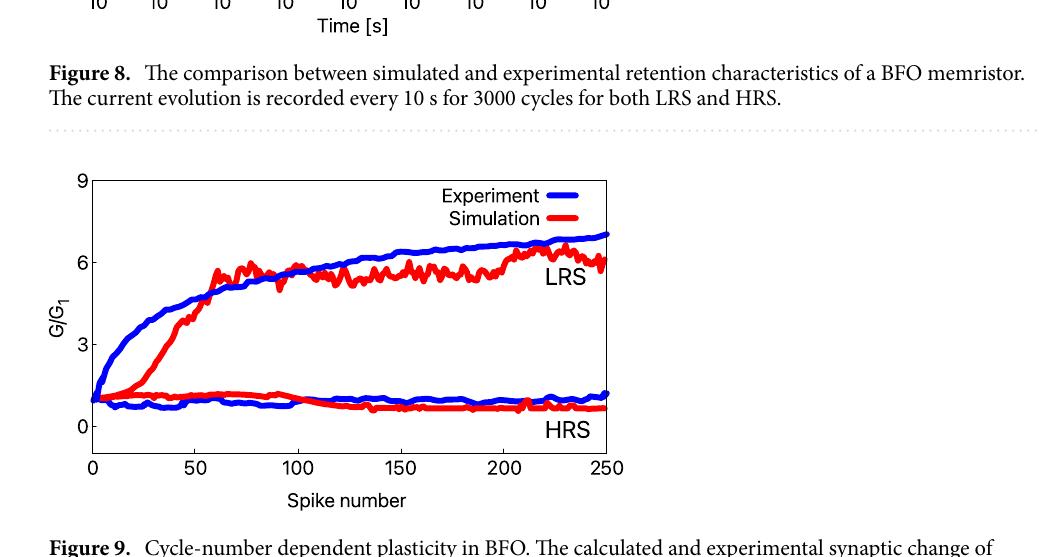
Figure 9. Cycle-number dependent plasticity in BFO. The calculated and experimental synaptic change of ( a ) potentiation and ( b ) depression dynamics. G 1 is the conductance measured during the first spike.